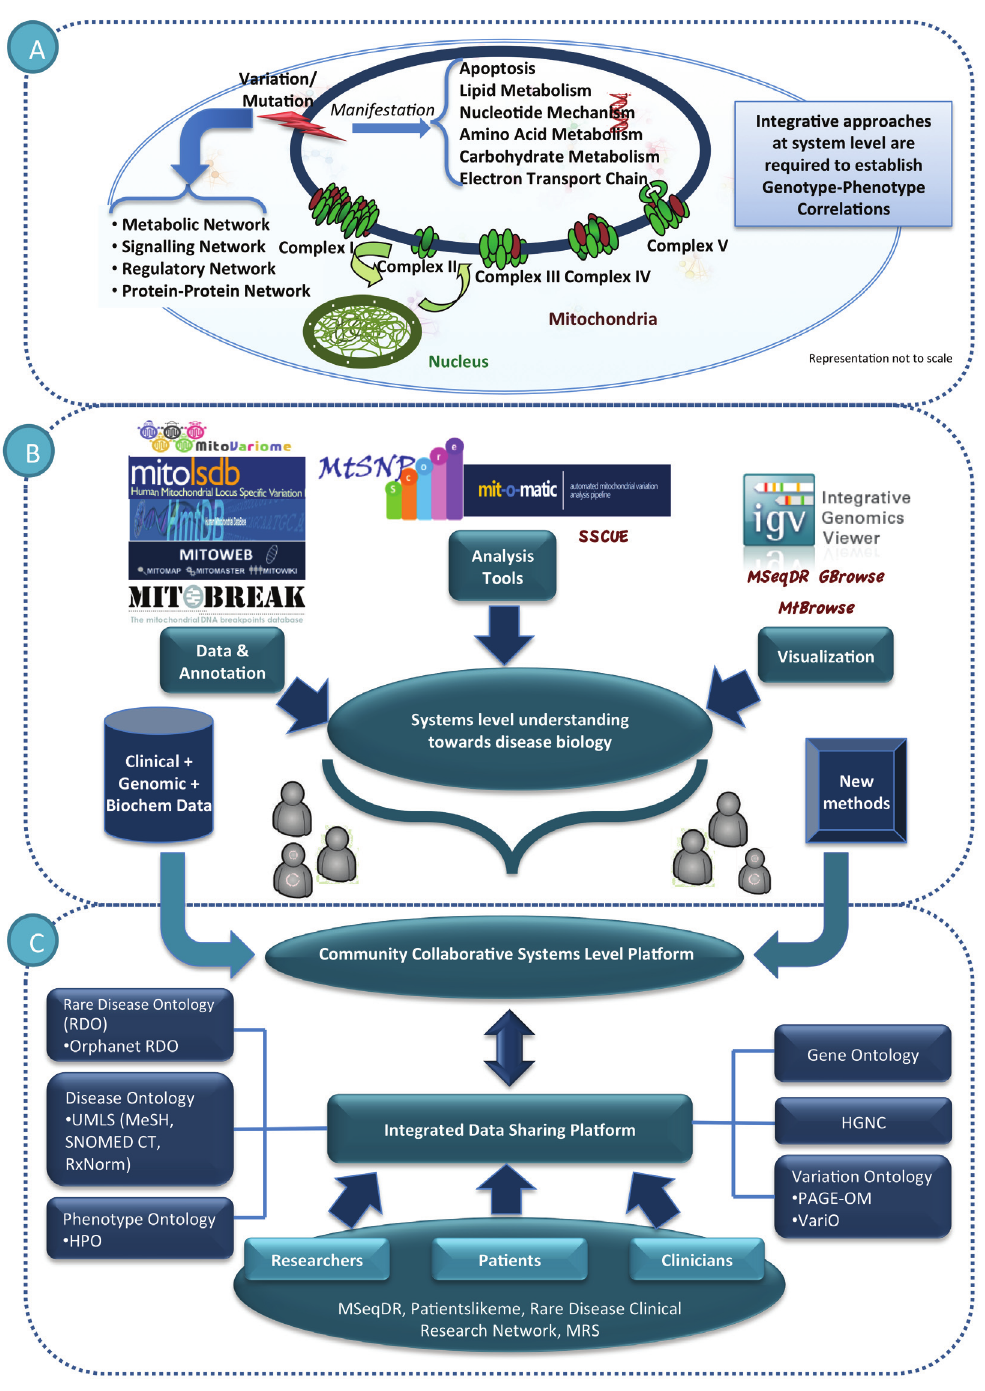
Figure 1. ( A ) This section describes the challenges involved in dissecting the impact of genomic variation in disease association. As shown, mitochondria are involved in a large number of cellular processes including energy metabolism. Genes encoded by mitochondrial and nuclear genomes carry out these functions. The protein subunits of the complexes of the electron transport chain are encoded both by mtDNA (red) and nDNA (green). In order to understand the complex genotype-phenotype correlation it is imperative to identify the molecular interactions at systems level (protein-protein interaction network, metabolic network, signaling network, regulatory network). It is important to curate the information needed to generate these networks from literature and existing resources. ( B ) The resources currently available for mitochondrial dysfunction include databases, web servers and analysis pipelines as shown. For generating systems level models, these resources may be integrated systematically. ( C ) There are various ongoing efforts involving researchers, clinicians and or patient groups. It is proposed that a community collaborative open access platform is a must to interface these communities. In order to establish such a platform that allows geographically different communities to work together, globally accepted ontologies in a language independent representation are